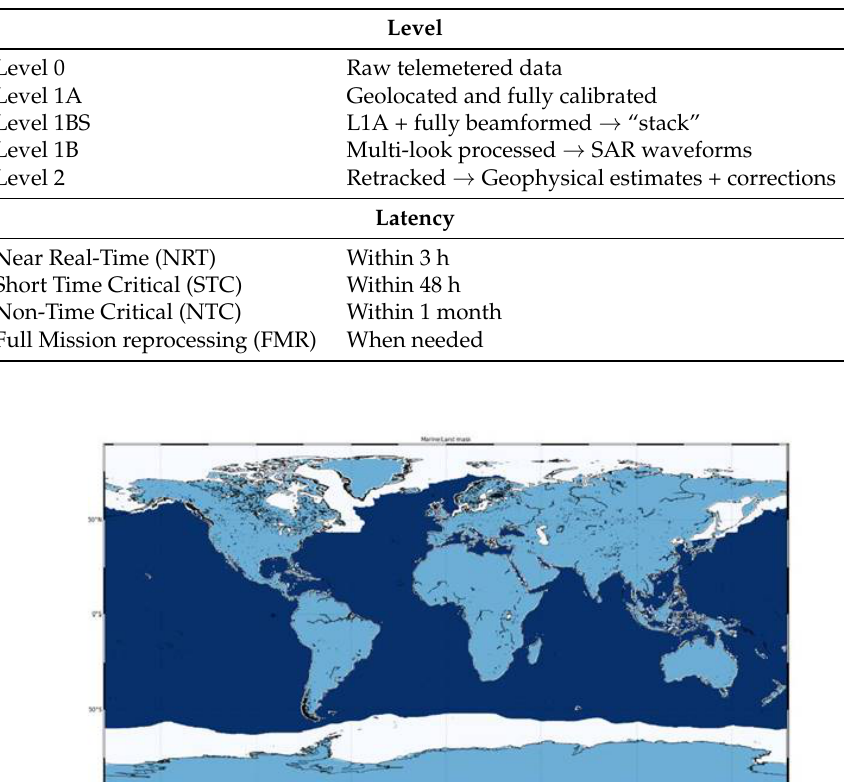
Table 1. Levels and latencies of Sentinel-3 STM processing. The NRT data are provided in segments as downloaded from the satellite; data for the other latencies are collated in pole-to-pole passes (half orbits).